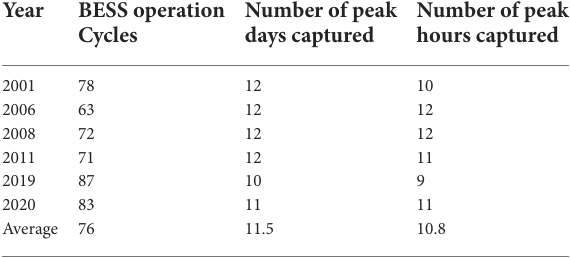
TABLE 6 Annual performance of BESS for 6 testing years using the proposed peak day and peak hour